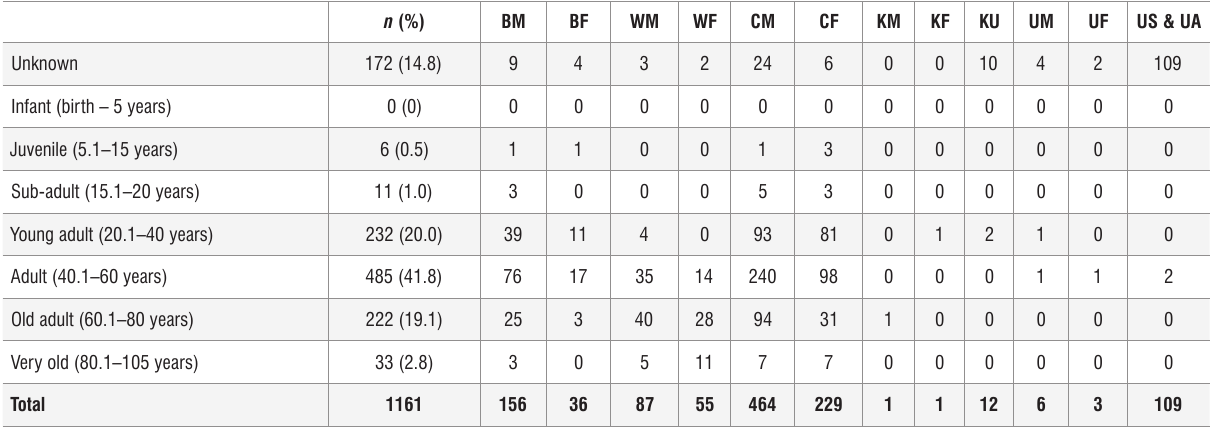
Population and age composition of the individuals in the Kirsten Skeletal